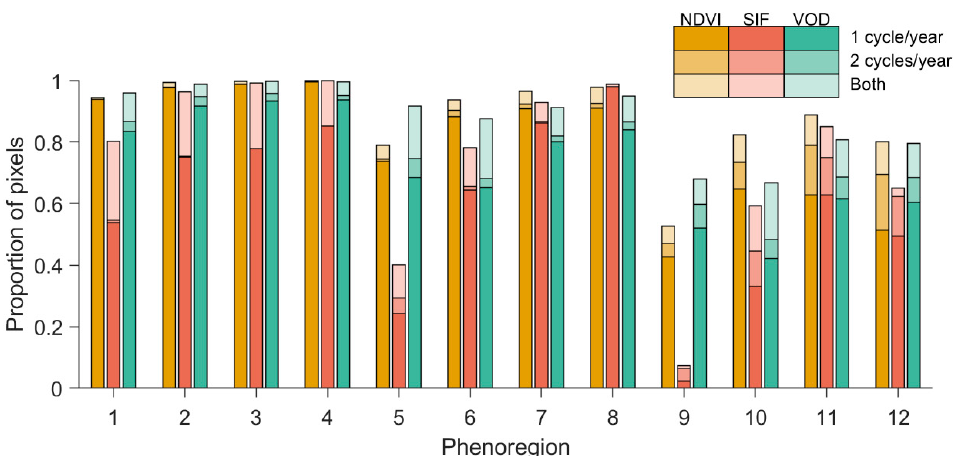
Figure 6. Percentage of pixels within each phenoregion with one or two (or both) phenological cycles per year for each index. The number of significant annual cycles for each index was determined by comparing the observed MTM power spectral density to those from an ensemble of noise-only time series with the same mean and variance as the vegetation index (e.g., Figure 2).